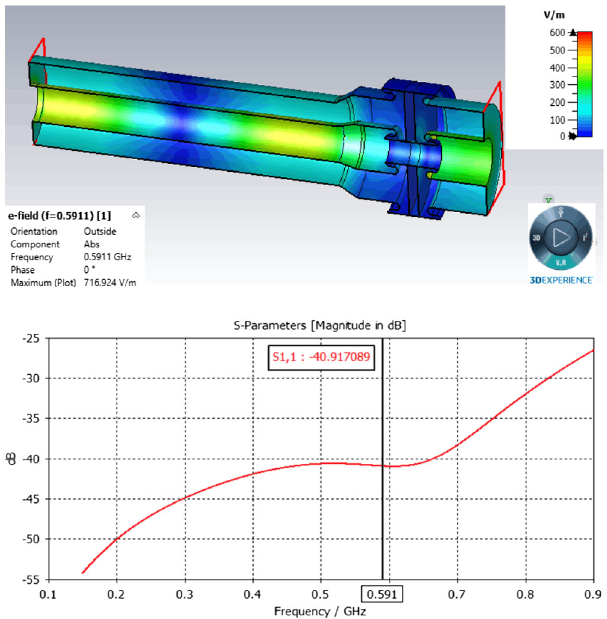
FIG. 4. BeO window (top) and new alumina window (bottom).